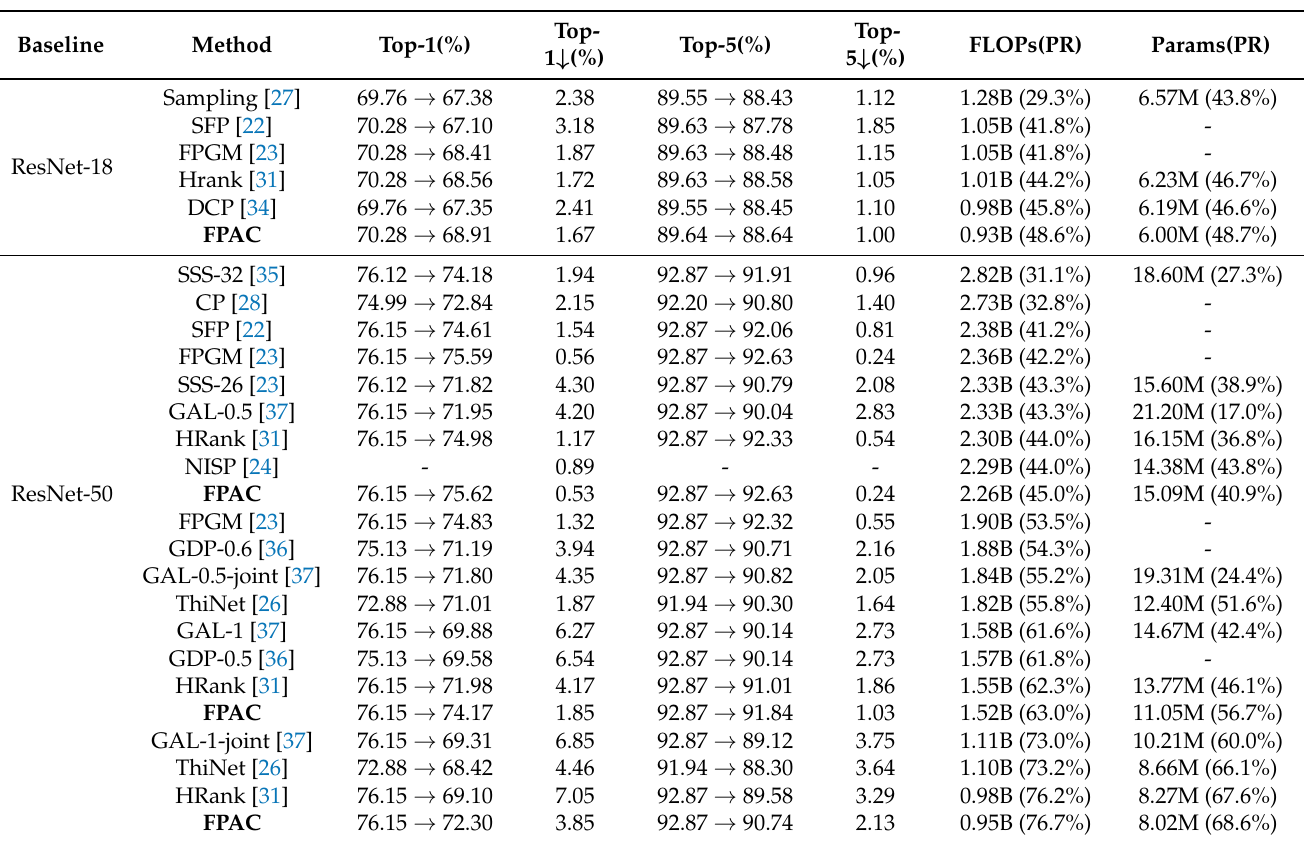
Table 2. Pruning results of ResNet on ImageNet. “Top-1”: accuracy. “Top-1 ↓ ”: decrease in accuracy, smaller is better. A negative value here indicates an improved model accuracy. “Top-5 ↓ ”: decrease of Top-5. “FLOPs(PR)”: FLOPs(pruning ratio). “Params(PR).”: parameters(pruning ratio). “-”: results not reported in the corresponding